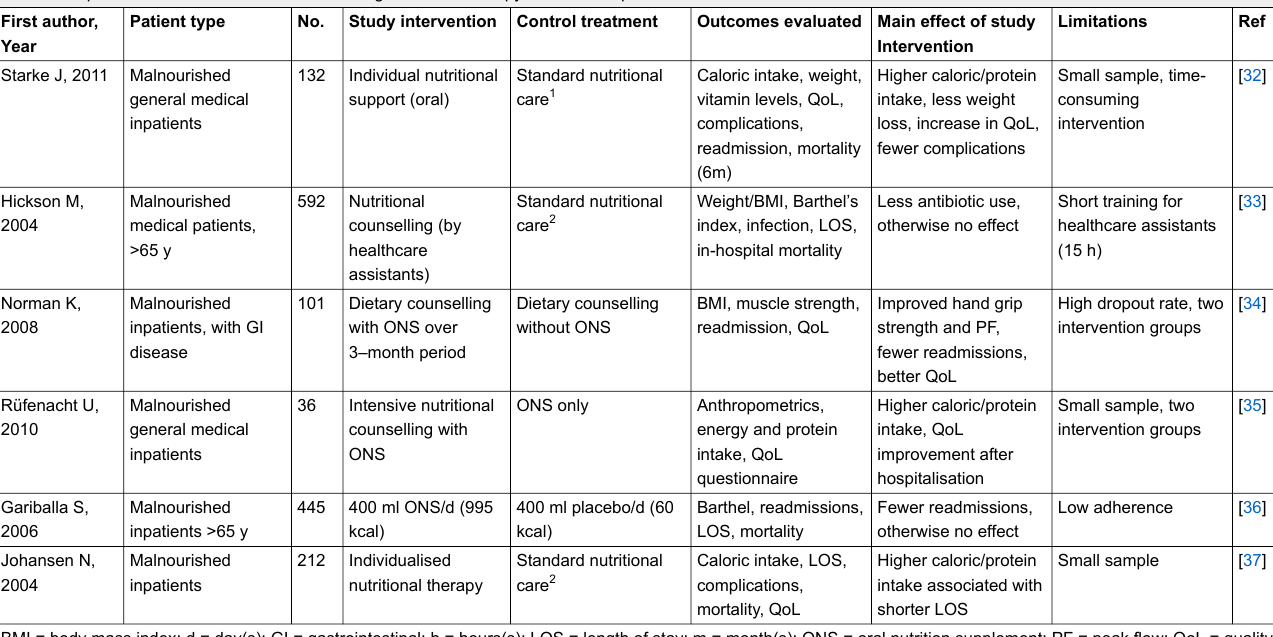
Table 1: Important interventional studies evaluating nutritional therapy in medical